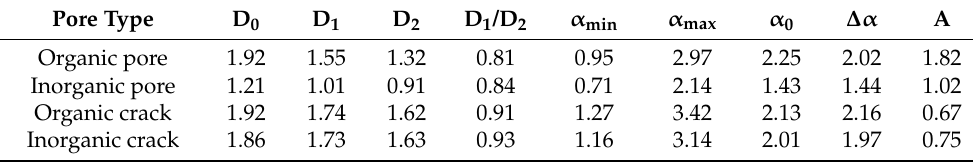
Table 2. Multifractal parameters of four pore